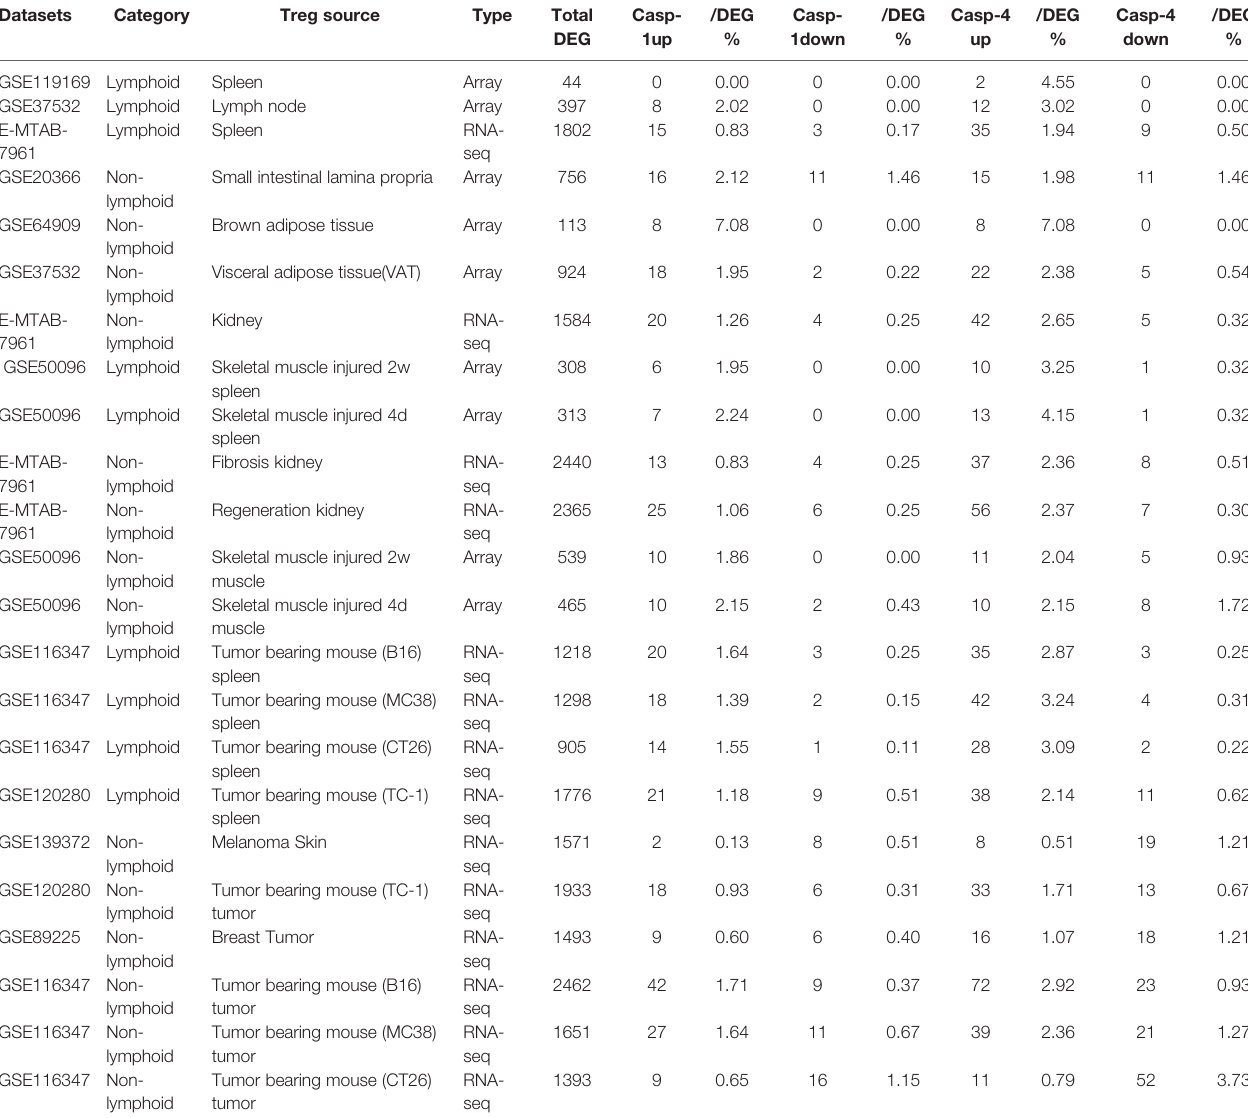
TABLE 3D | Gene numbers of caspase-4 dependent GSDMD secretomes were more than caspase-1 dependent GSDMD secretomes in various Treg groups.